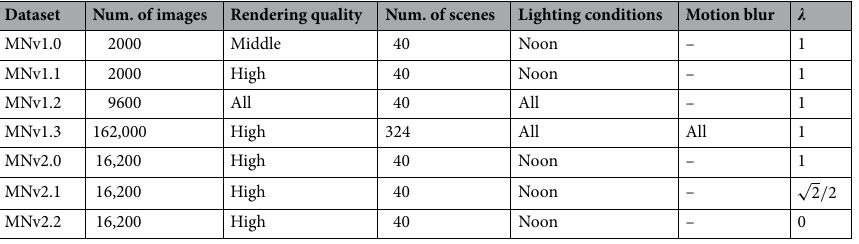
Table 1. Builded MineNavi